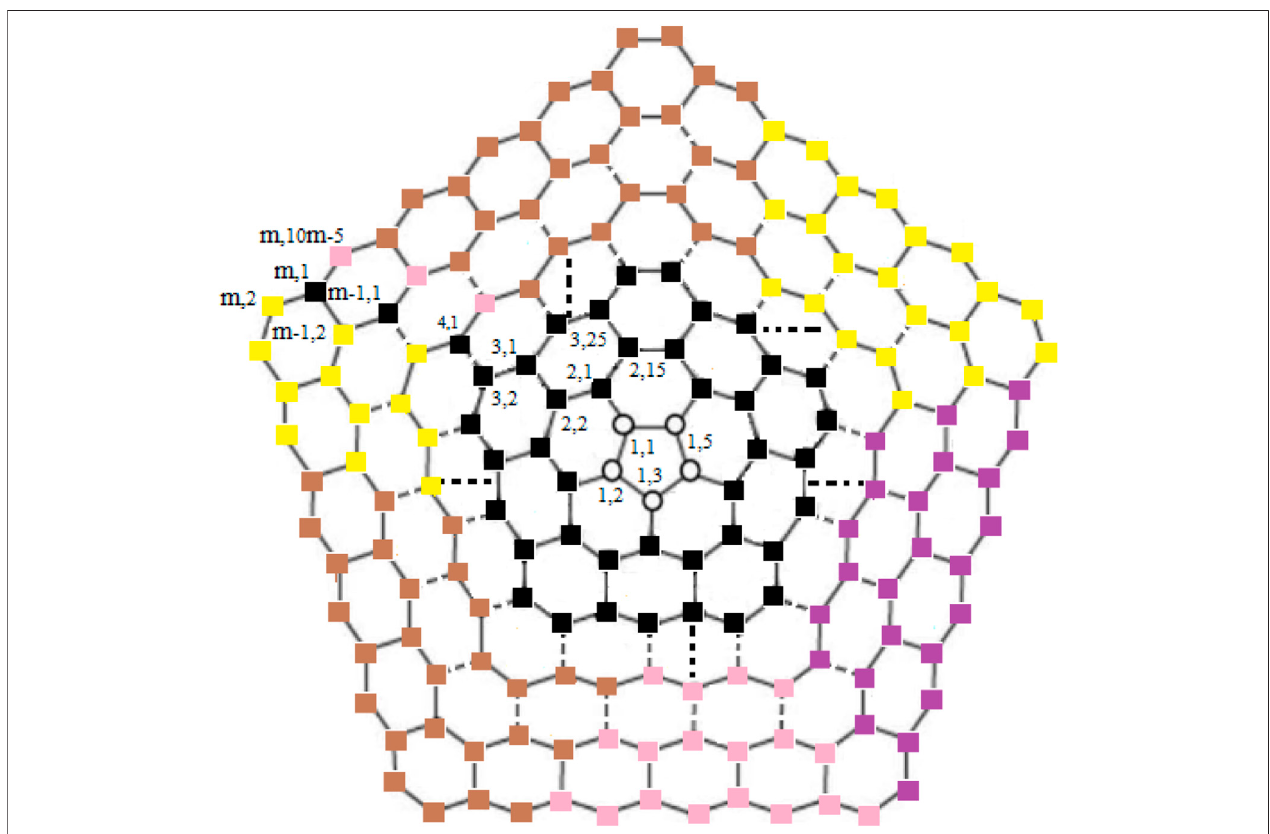
FIGURE 4 | CNC 5 [m] for Case 2.